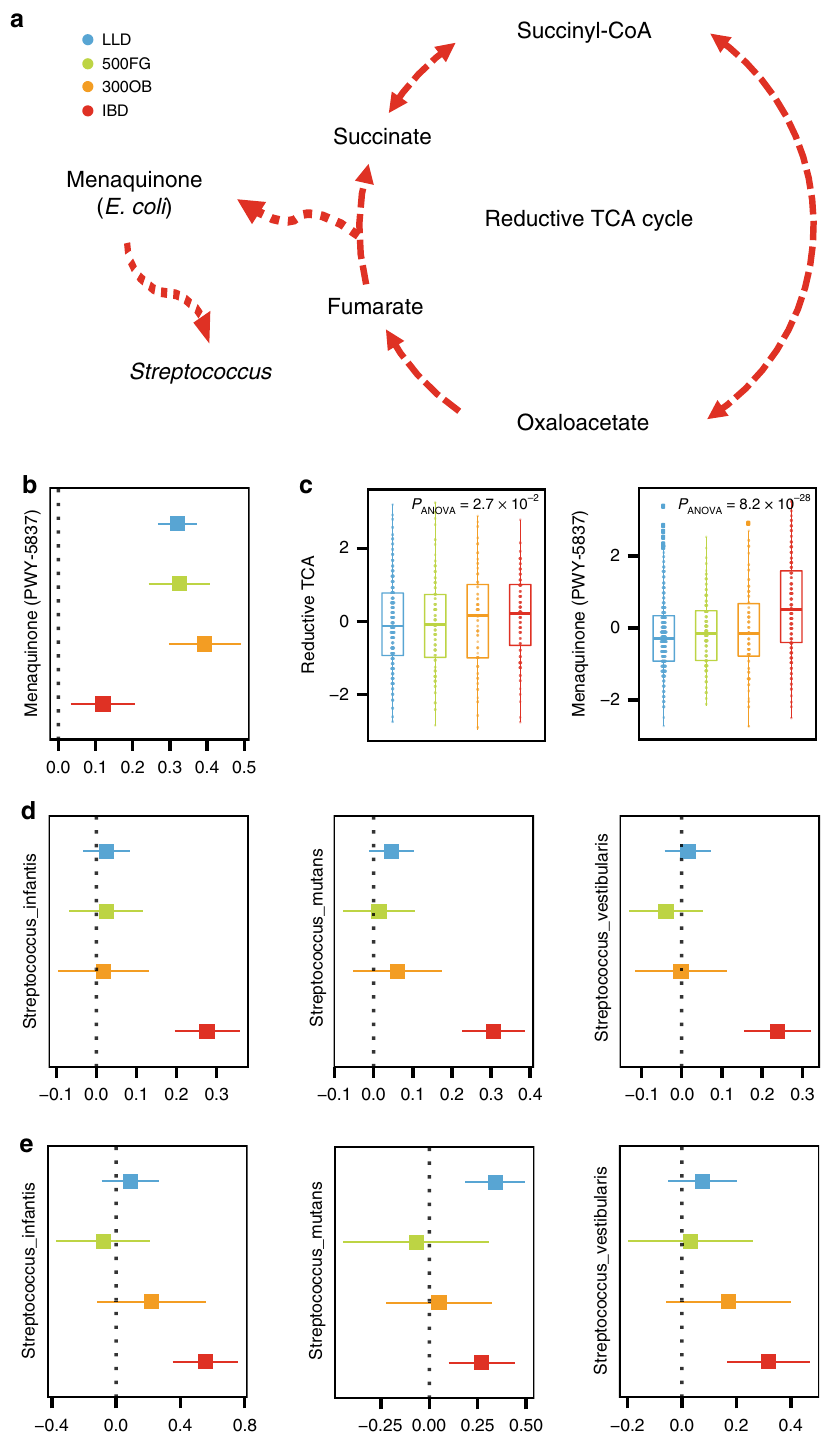
Fig. 5 Menaquinone biosynthesis related to Streptococcus overgrowth in IBD. a Menaquinone biosynthesis (PWY-5837) from the reductive TCA cycle (P23-PWY) in bacteria. b The menaquinone biosynthesis pathway shows IBD-speci fi c interaction with the reductive TCA cycle pathway. c Both menaquinone biosynthesis and reductive TCA cycle pathway abundance are signi fi cantly higher (ANOVA test, FDR < 0.05) in the IBD cohort than in the two population-based cohorts. Box plots show medians and the fi rst and third quartiles (the 25th and 75th percentiles) of abundance after correcting for age and sex, respectively. The upper and lower whiskers extend the largest and smallest value no further than 1.5 × IQR, respectively. Outliers are plotted individually. (Source data is provided as a Source data fi le). d Three Streptococcus species show IBD-speci fi c co-abundance with Escherichia coli . e The menaquinone biosynthesis pathway shows strong positive correlation with three Streptococcus species in IBD. N = 2379 independent samples are involved ( N LLD = 1135, N 500FG = 450, N 300OB = 298, N IBD = 496). The forest plots show co-abundance strength and direction in each cohort, with square dot for the correlation coef fi cient and bar for the 95% con fi dence